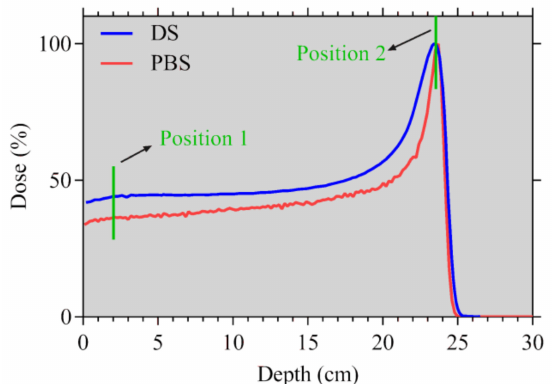
Figure 6. The percentage depth–dose curves for the selected beam energies for PBS and DS. The grey vertical lines symbolize the two irradiation positions of the cell